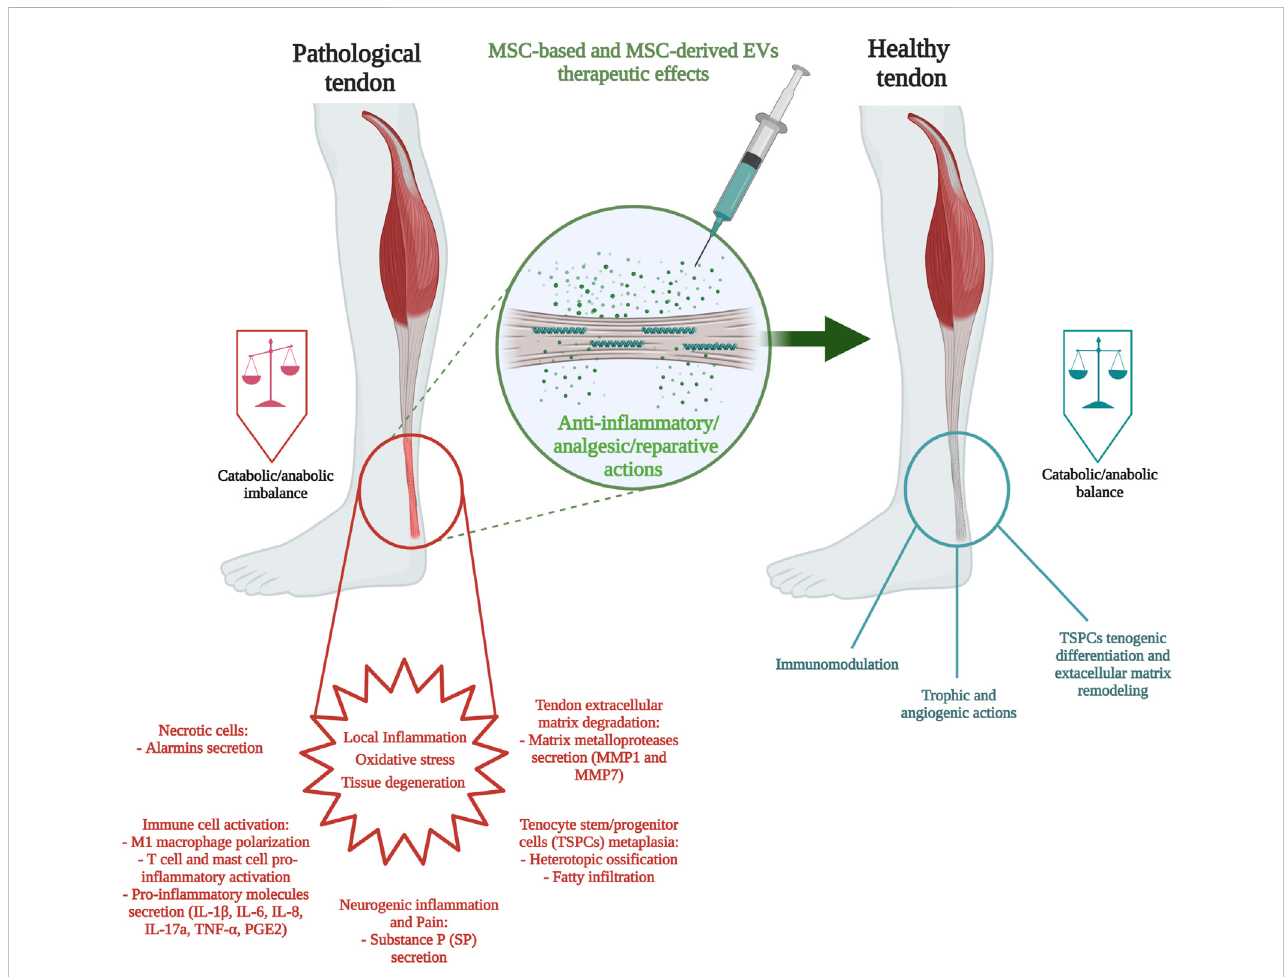
Components of tendon pathology and MSC-based/MSC-derived extracellular vesicle therapeutic